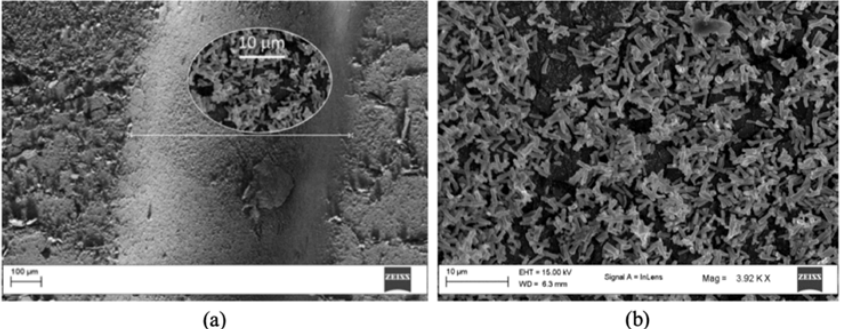
Figure 5. SEM image of the channel region of the PDMS mofd after ZnO growth ( a ); high resolution image of ZnO nanostructures inside channel ( b ).